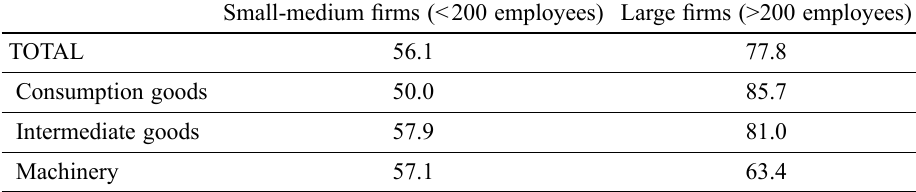
Table 2 . Percentage of firms with majority position on their main subsidiary